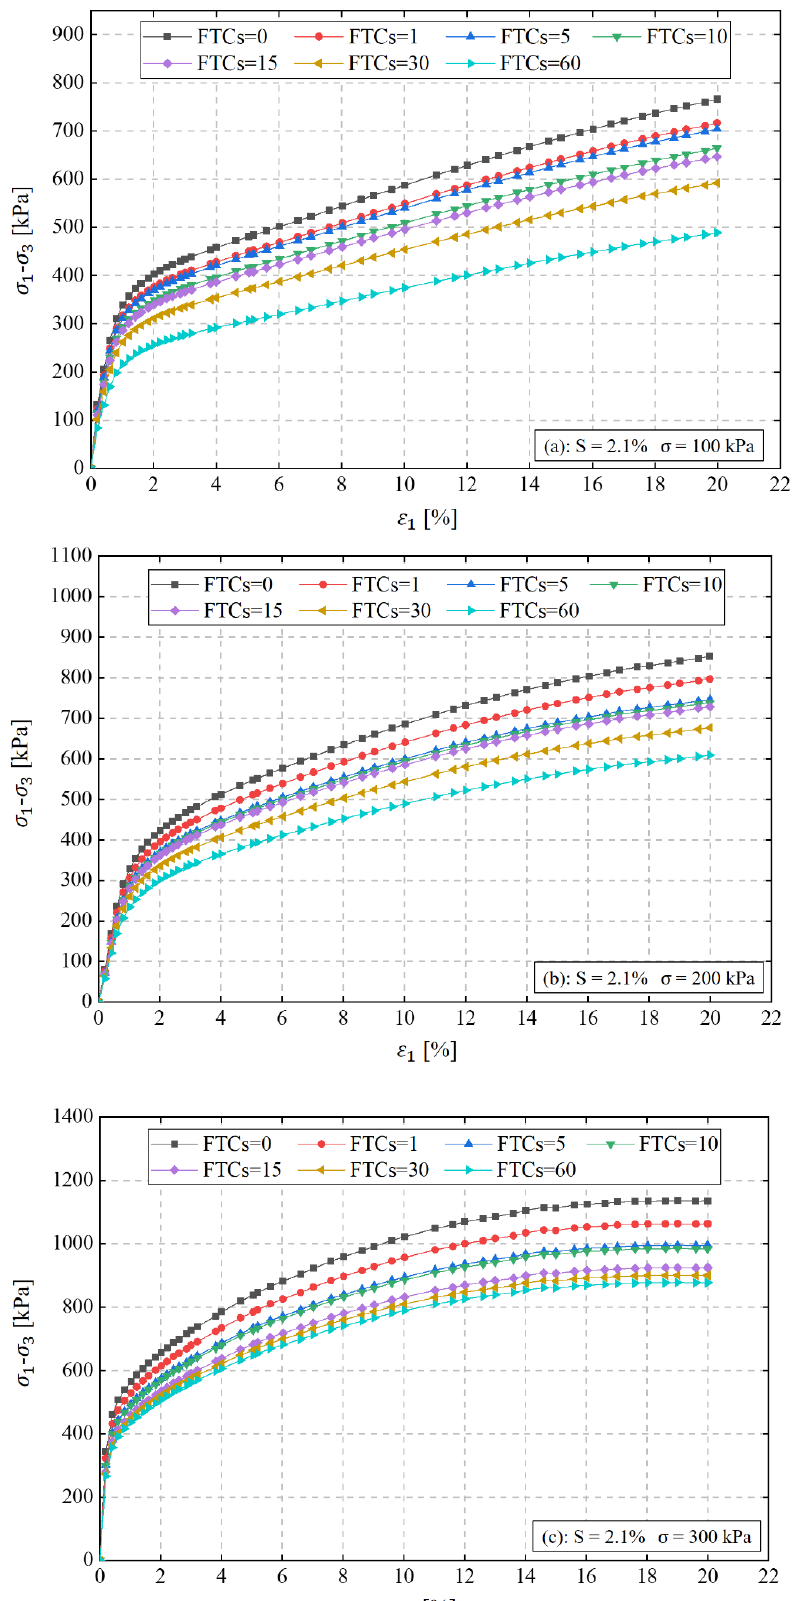
Figure 7. Stress-strain behavior of the specimens (S = 0.6%) at an increasing number of FTCs varying